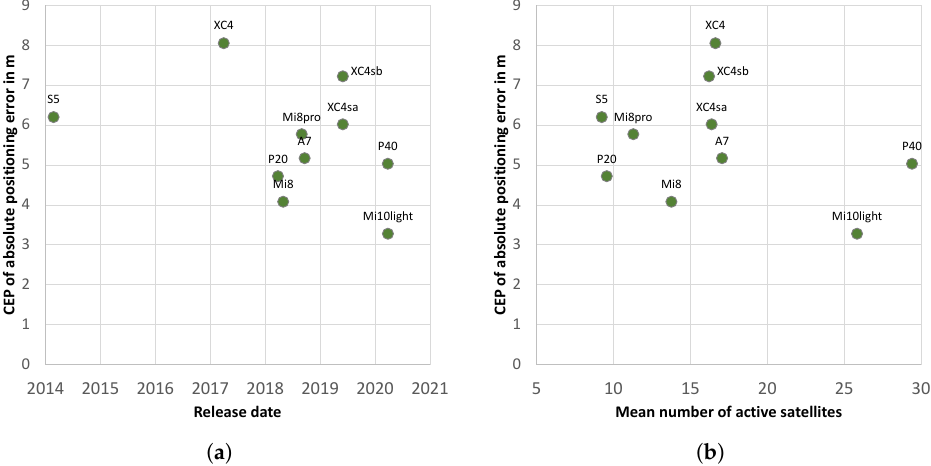
Figure 9. Correlation between the absolute position error (CEP) and ( a ) the release date and ( b ) the mean number of active satellites used by the smartphones used in the